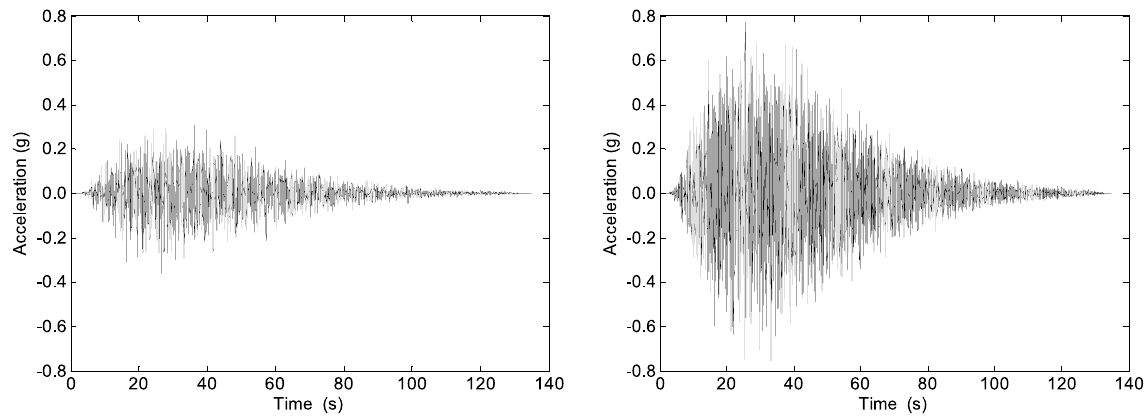
Fig. 6. Spectrum compatible ground motion (left) and corresponding absolute acceleration response of roof mass (right) for fi xed